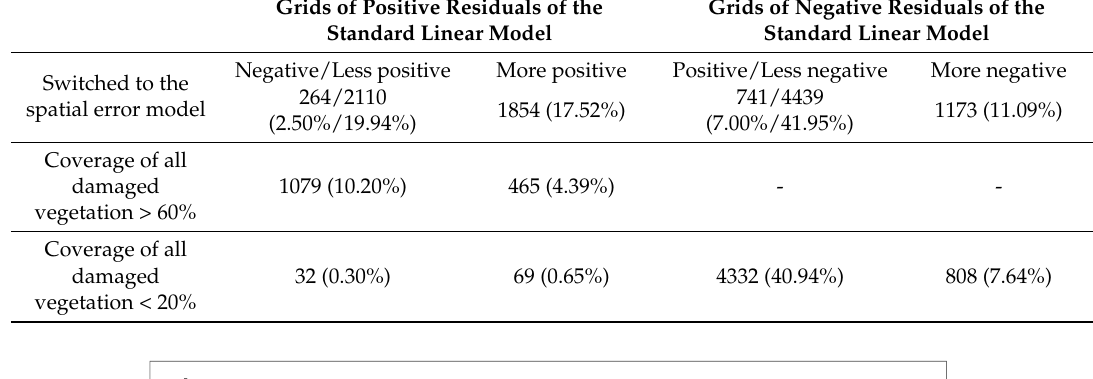
Table 8. The grids and percentages of the residuals of the standard linear model switched to the spatial error model at aggregation level 1 × 1.